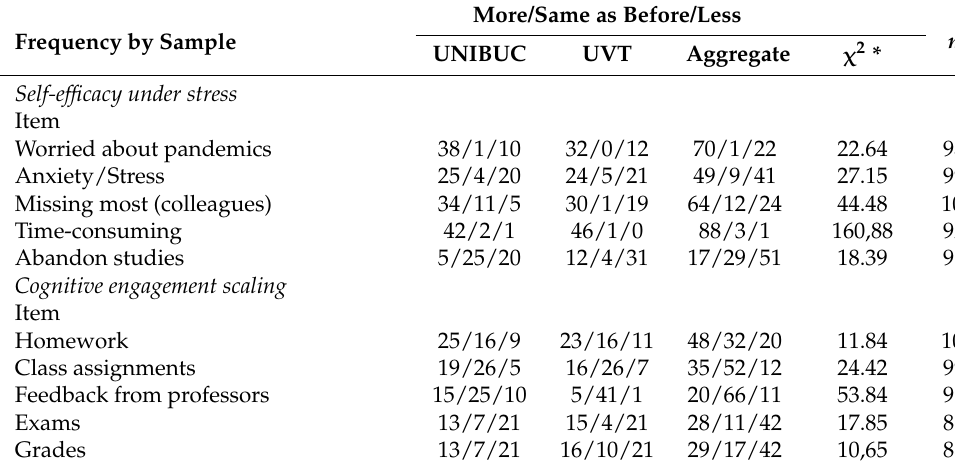
Table 2. Distribution of perceived abilities to perform online education tasks.